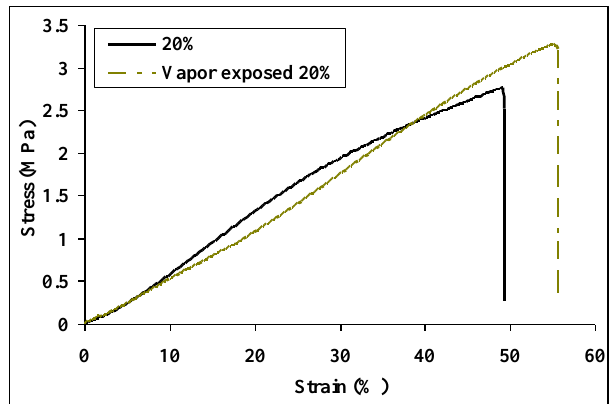
Figure 5. Typical stress-strain plots of nylon 6 non-woven fiber mats electrospun from 20 wt % solutions before and after formic acid vapor exposure for 30 min at room temperature. Table 3. Tensile properties of nylon 6 non-woven fiber mats electrospun from 20 wt % solutions before and after formic acid vapor exposure for 30 min at room temperature.